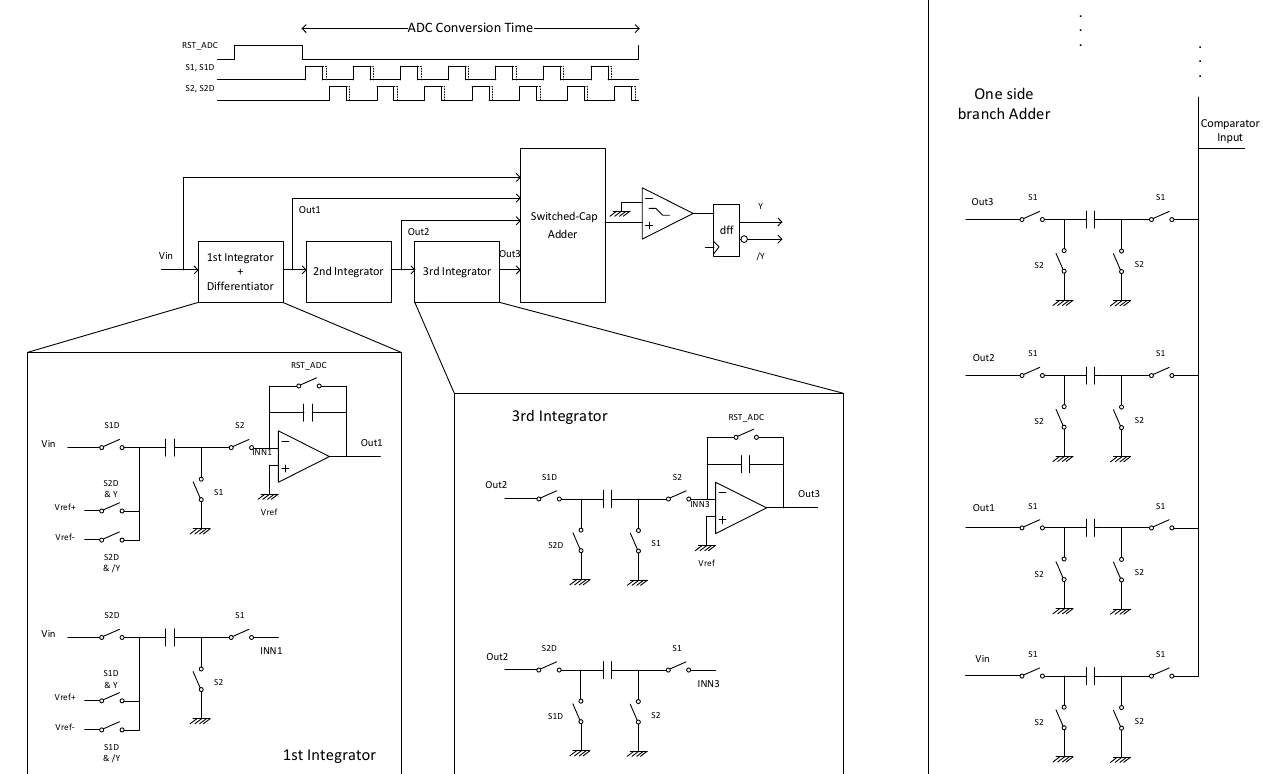
Figure 9. High-level implementation of the dual-cycled 3rd order ISD modulator concept. The several modulator blocks match with Figure 8 stages, except for the digital filter.